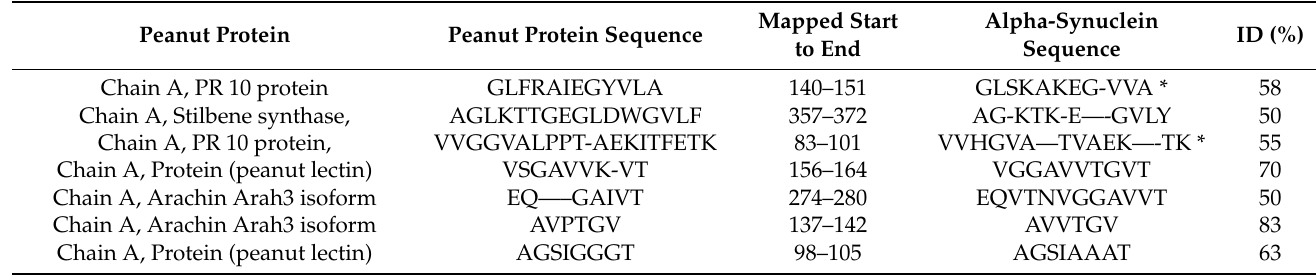
Table 7. Potential cross-reactive epitopes between alpha-synuclein proteins and peanut proteins.